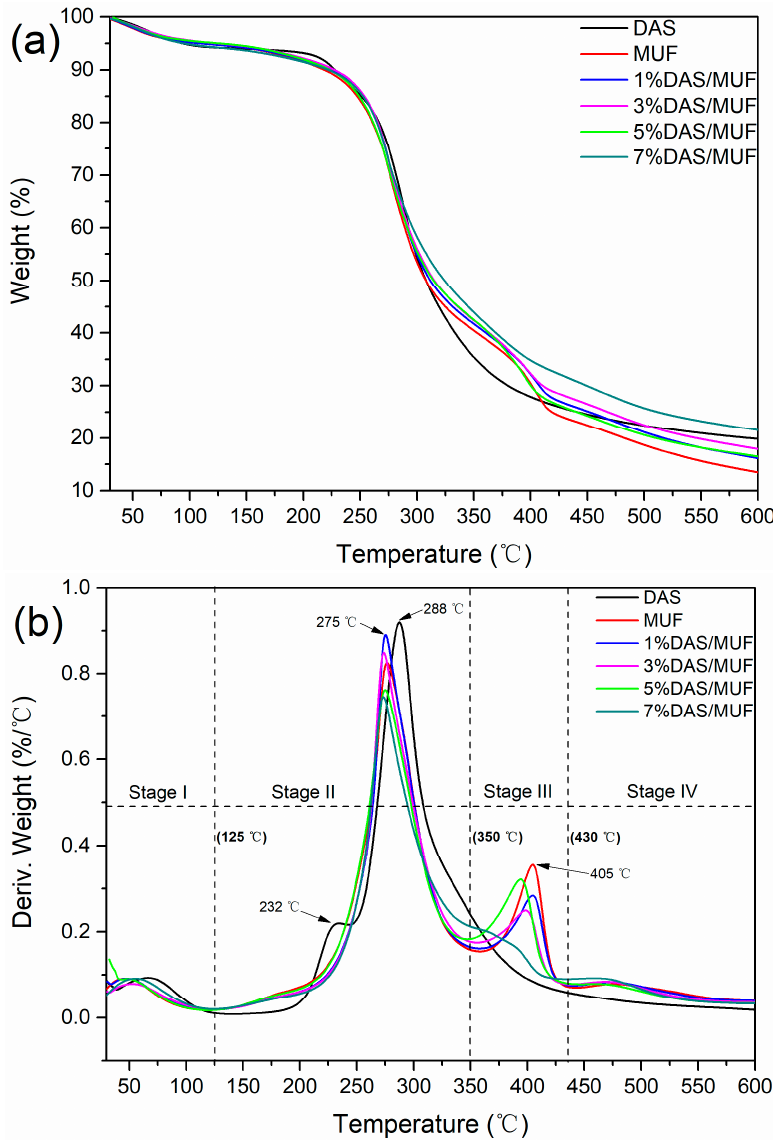
Figure 8. Thermogravimetric ( a ) and derivative thermogravimetric ( b ) curves of DAS, the cured MUF resin and DAS-modified MUF resins with di ff erent DAS